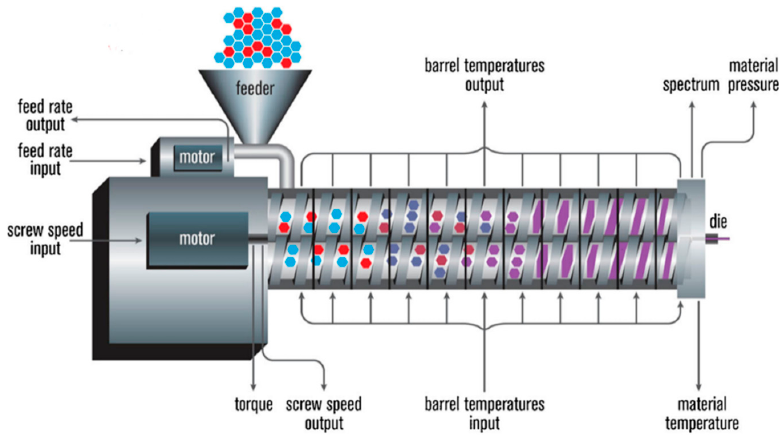
Figure 1. A schematic diagram of a typical hot melt extruder (Reproduced with permission from reference [17] , Springer, 2015).